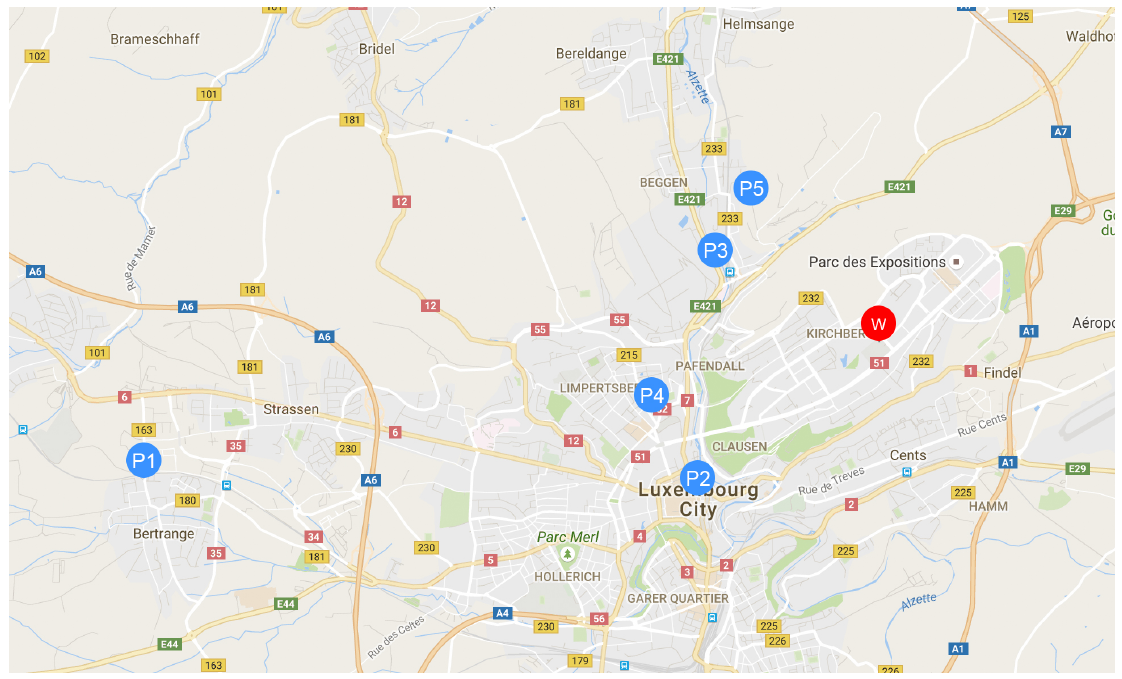
Figure 3. Home ( P 1 – P 5 ) and work (W) locations of the respondents.